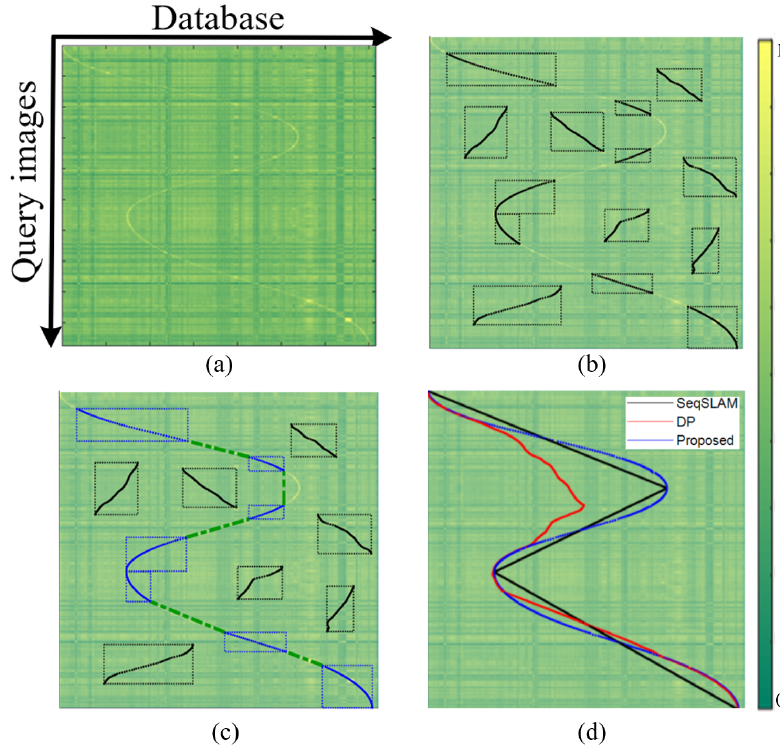
Figure 7. Experimental results: ( a ) constructed similarity matrix; ( b ) detected local fragments; ( c ) rectangle chained results; ( d ) global alignment results compared to other